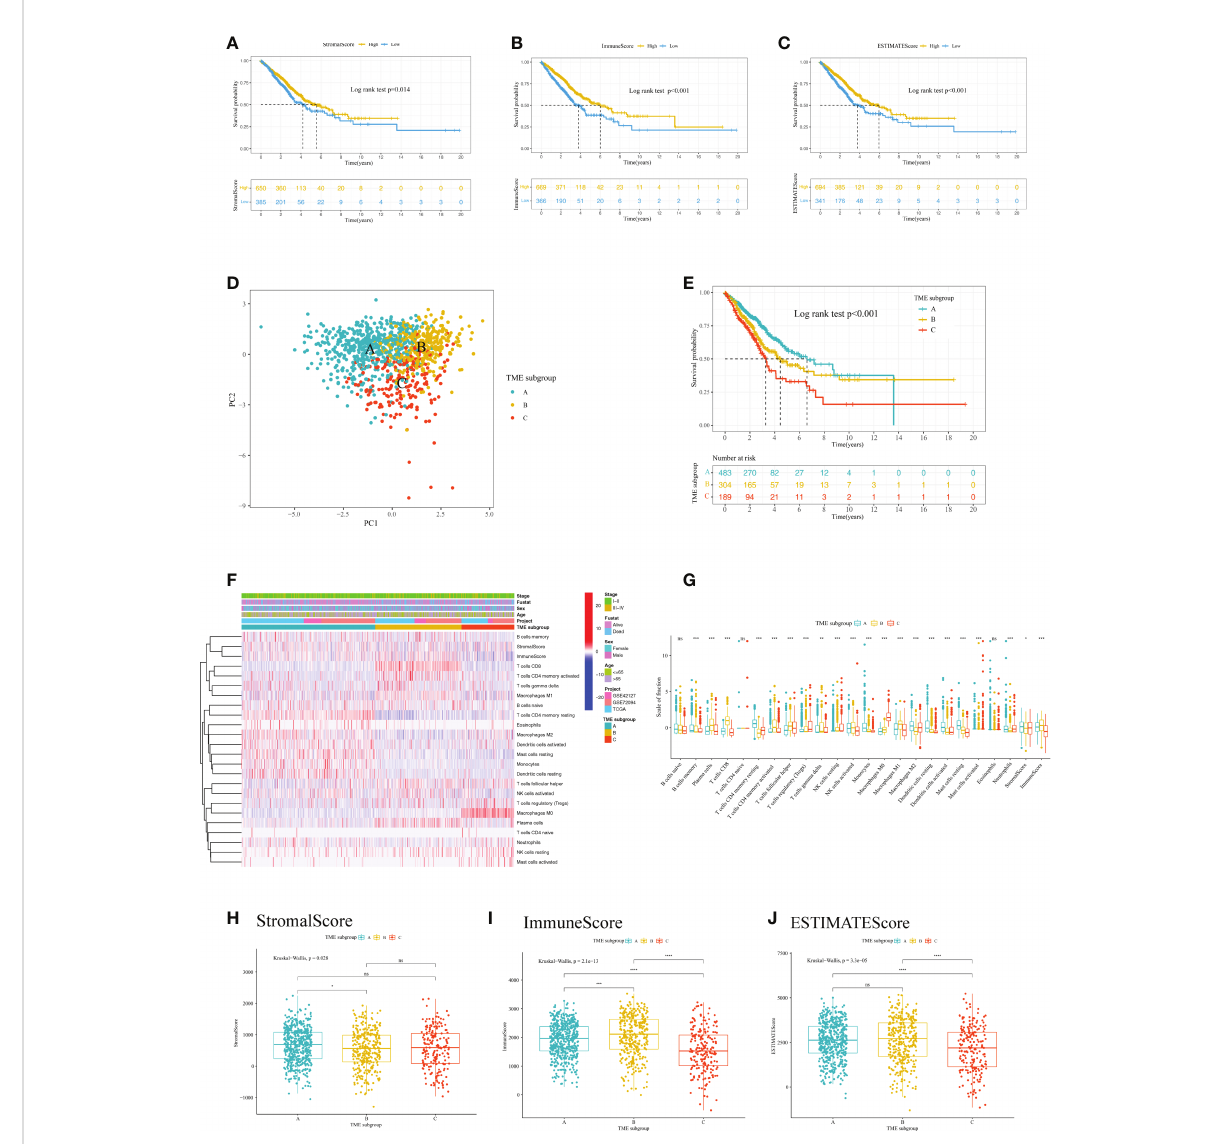
FIGURE 2 Analysis of the immune cell in fi ltration and TME scores of patients with LUAD. Kaplan – Meier curve analysis of the OS for different levels of (A) StromalScore, (B) ImmuneScore, and (C) ESTIMATEScore. (D) PCA for the immune cell in fi ltration level of the three TME subgroups, showing a remarkable difference in immune cell in fi ltration levels between different subgroups. (E) Kaplan – Meier curve analysis for the OS of patients with LUAD in different TME subgroups. (F) Heatmap of the 22 TIICs in different LUAD cohorts. Rows represent TIICs, and columns indicate LUAD samples. (G) The fraction of 22 TIICs, StromalScore, and ImmuneScore were compared between different TME subgroups using the Kruskal- Wallis test. The Kruskal – Wallis test was used to compare the statistical difference of (H) StromalScore, (I) ImmuneScore and (J) ESTIMATEScore of the three TME subgroups. *p< 0.05; **p< 0.01; ***p< 0.001; ****p< 0.0001; ns, no signi fi cance. LUAD, lung adenocarcinoma; TME, tumor microenvironment; OS, overall survival; PCA, principal component analysis; TIIC, tumor in fi ltrating immune